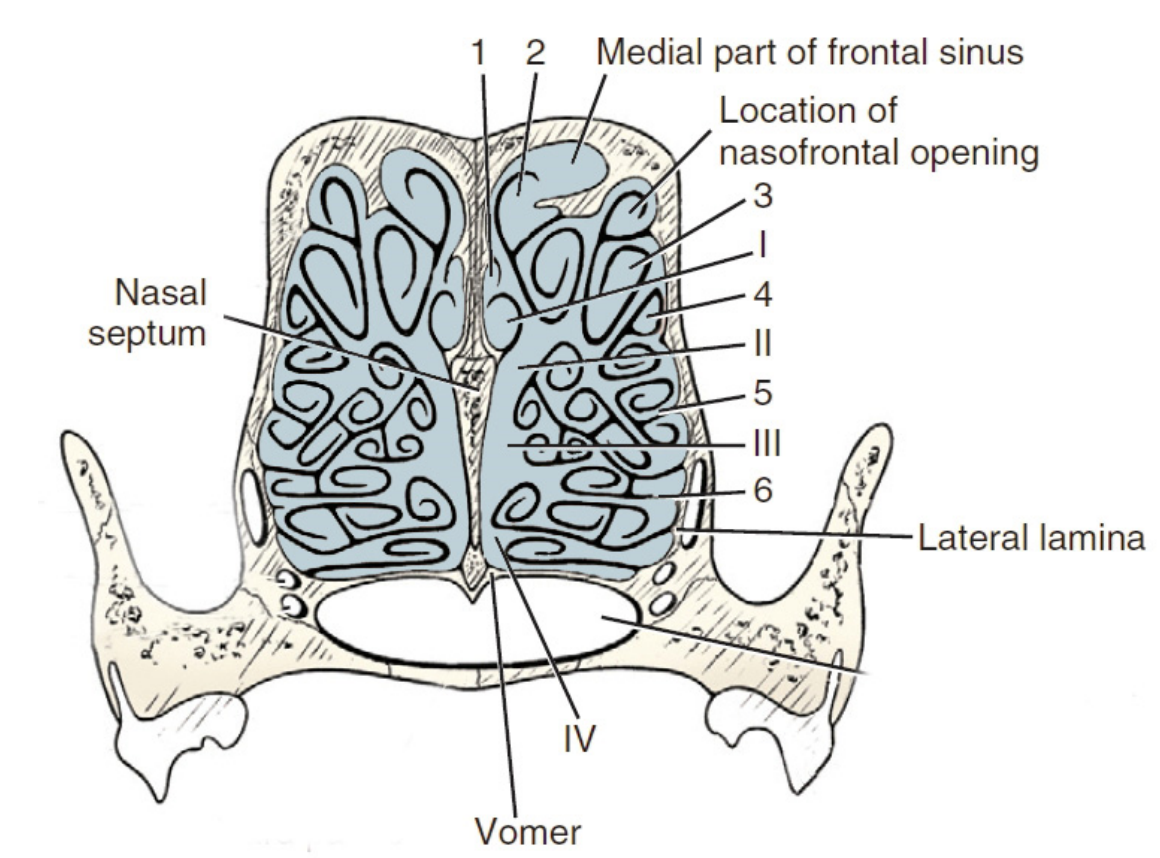
Figure 4. Transverse section of the ethmoturbinates in dogs. I, II, III, IV—endoturbinates; 1, 2, 3, 4—ectoturbinates. Based on [21].